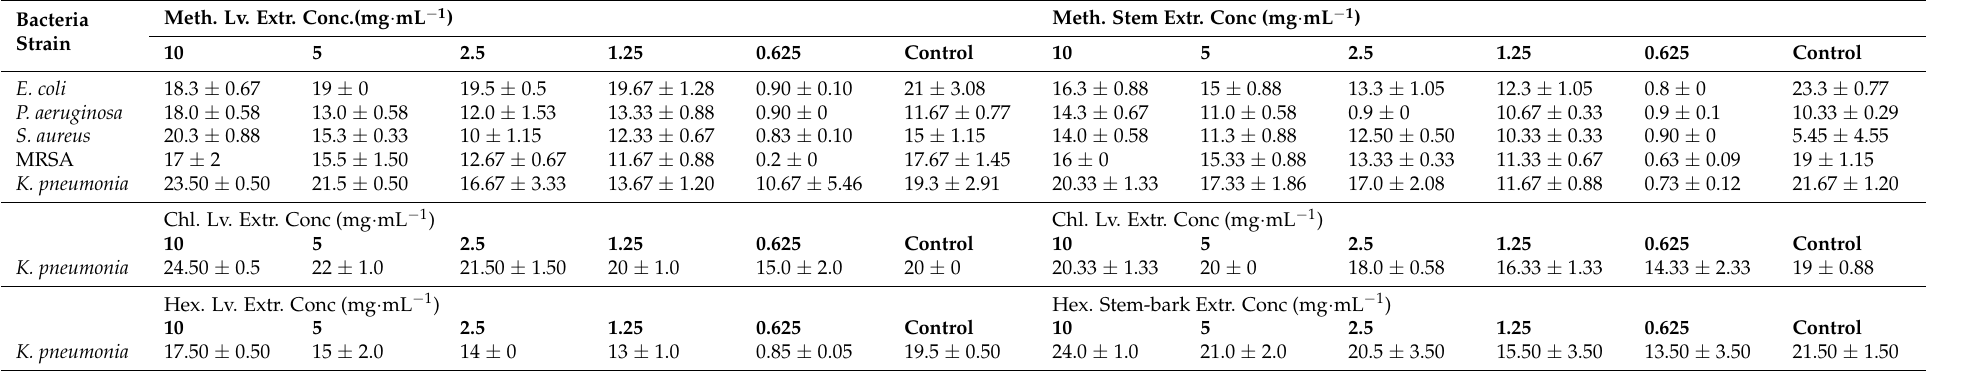
Table 9. Zone of inhibition (mm) of the graded doses of D. villosa leaf and stem-bark extracts against bacteria strains. Bacteria